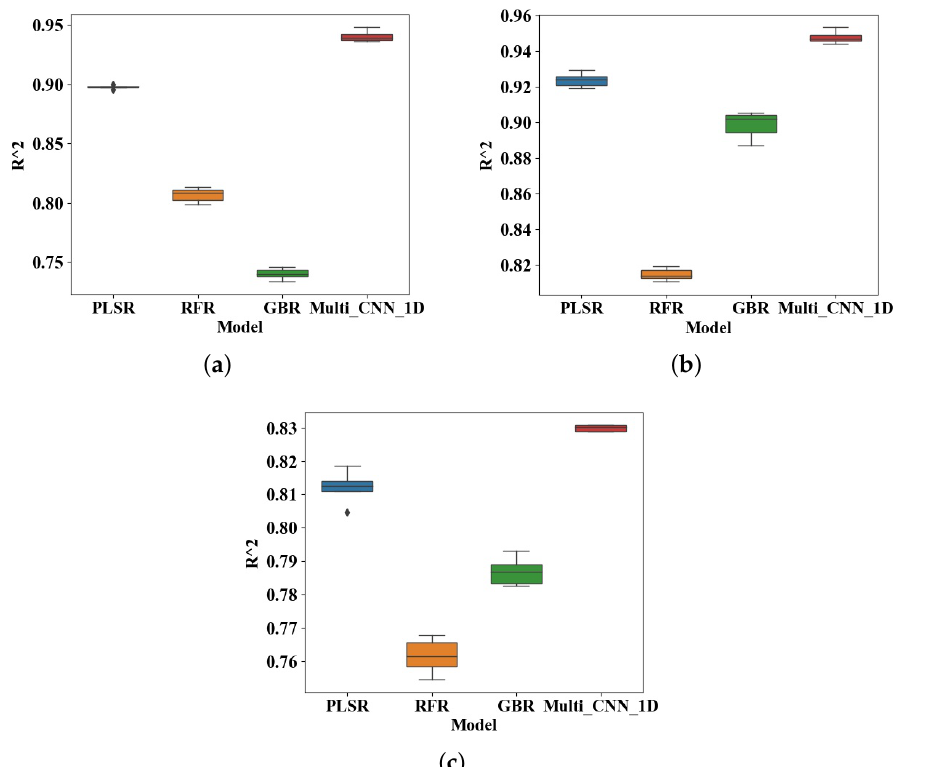
Figure 8. R 2 comparison box diagram of predicted values of ( a ) Total Carbon ( b ) Total Nitrogen ( c ) Alkaline